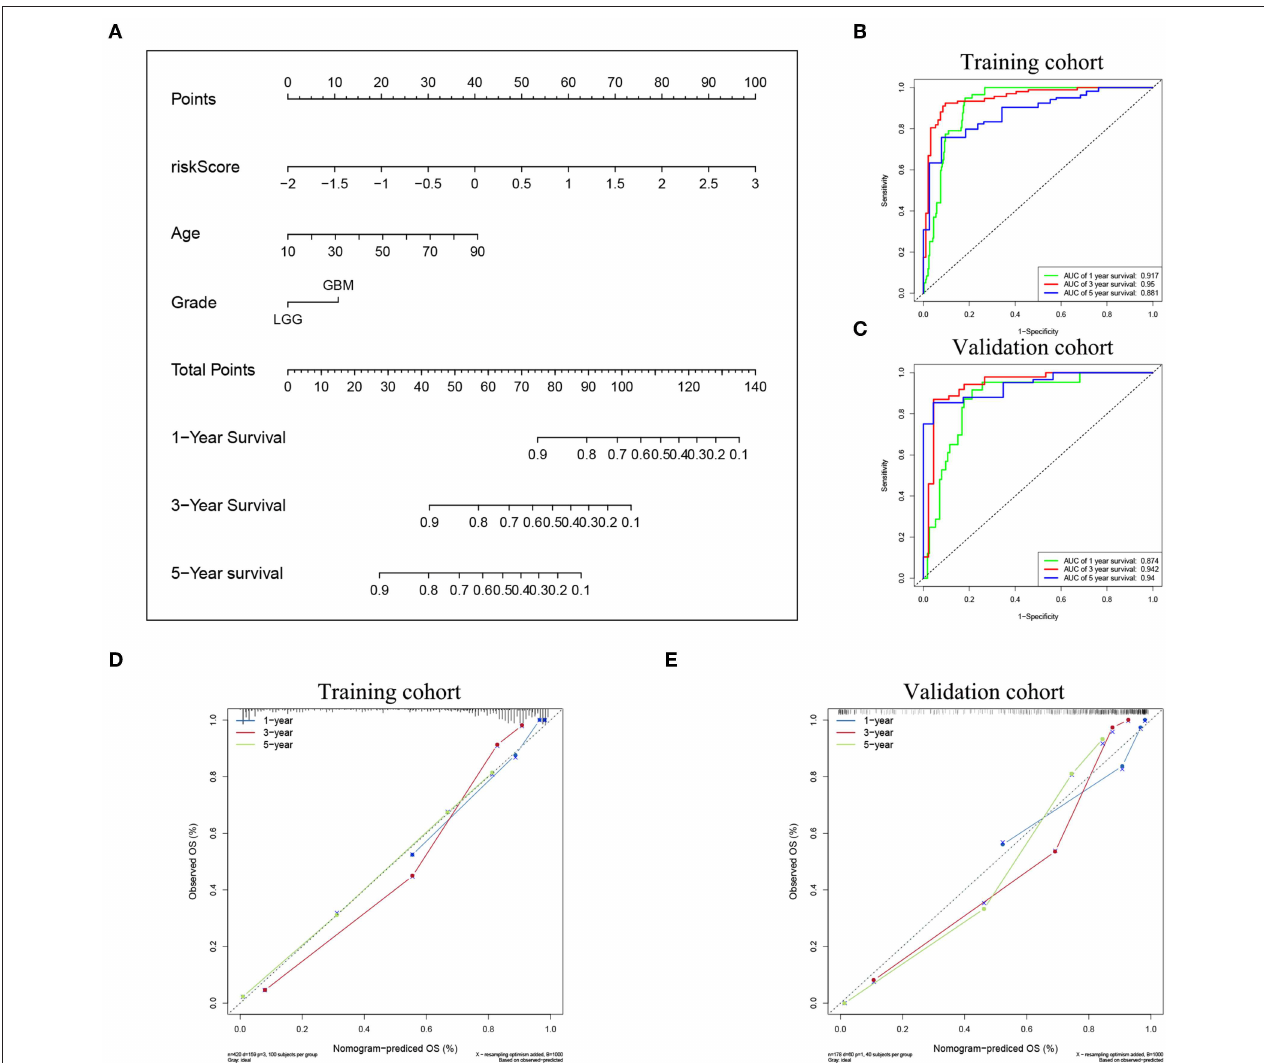
FIGURE 5 | Nomogram for predicting the survival rate of glioma patient. (A) A nomogram was established based on the risk signature, age, and grade for predicting survival of glioma patient. ROC curves were used for evaluating the efficiency of the nomogram. (B) AUCs for predicting 1-, 3-, and 5-year survival were 0.917, 0.95, and 0.881, respectively, in the training cohort. (C) AUCs for predicting 1-, 3-, and 5-year survival were 0.874, 0.942, and 0.94, respectively, in the validation cohort. Calibration plot of observed and predicted probabilities for the nomogram in the training cohort (D) and validation cohort (E)